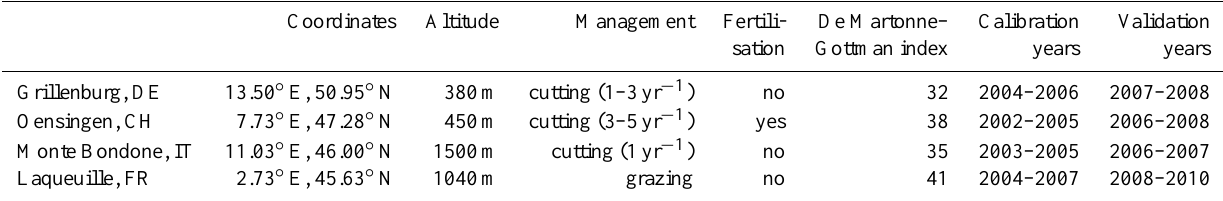
Table 1. Grassland sites and periods of simulations.